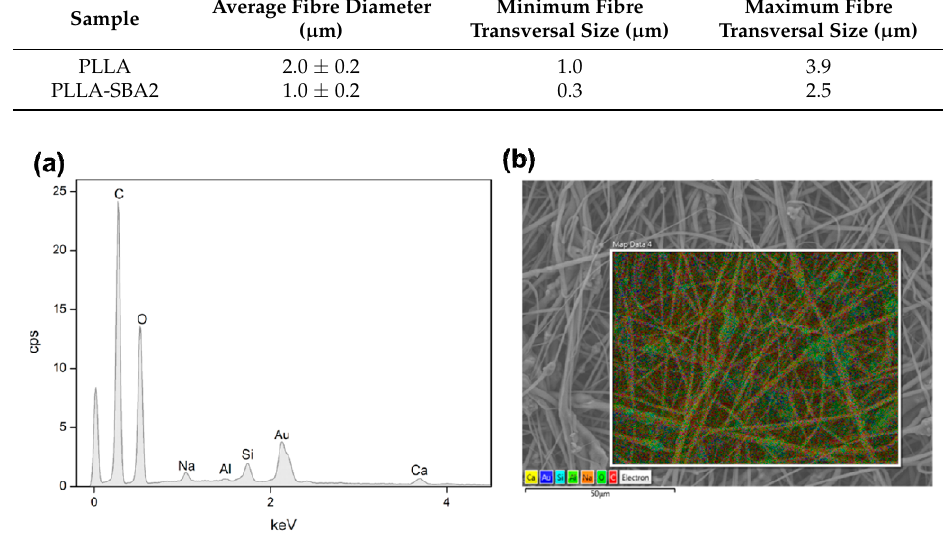
Figure 3. EDS spectrum of electrospun PLLA-SBA2 fibres ( a ) and its comparative SEM-EDS layered image ( b ) showing peaks of SBA2 constituents such as Ca (yellow), Na (orange) and Si (cyan). O (bright green) and C (red) are mainly related to PLLA.